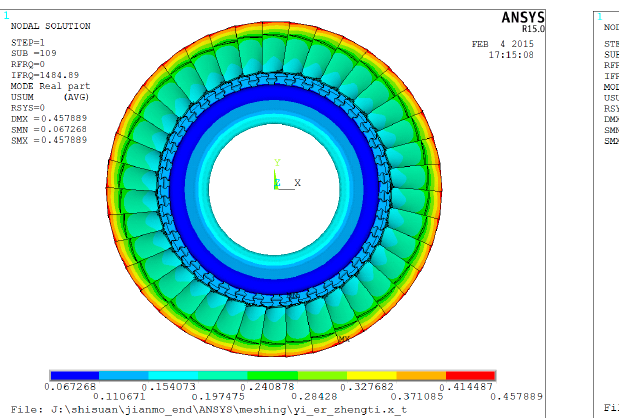
Figure 31. Mode 104.